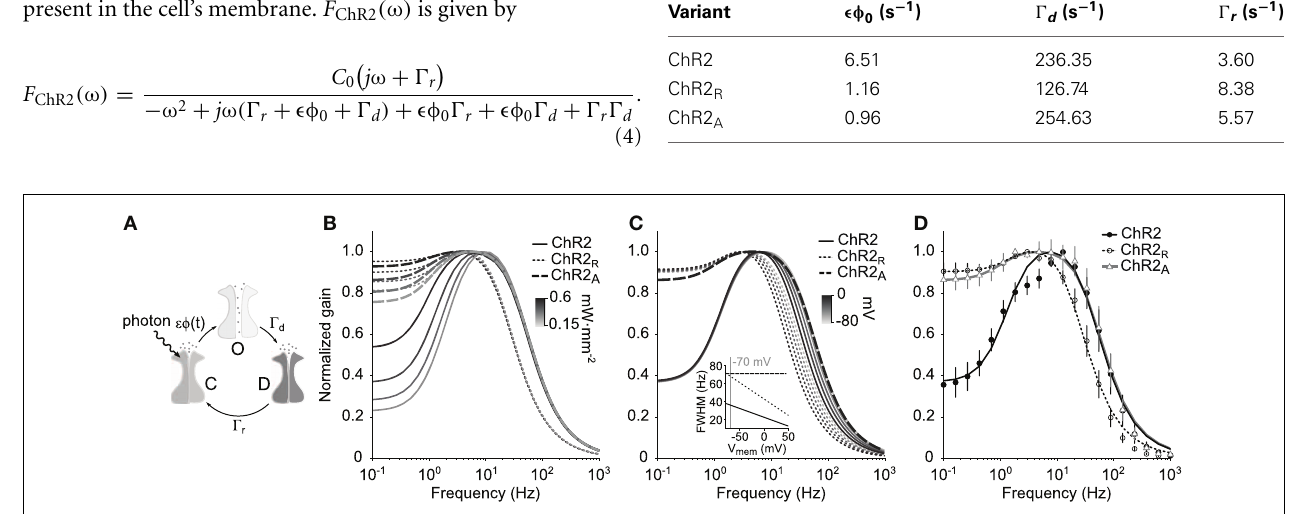
response function. ChR2 and ChR2 R both have a voltage-dependent desensitization rate, (cid:2) d ( v ) , which results in decreased bandwidth as the membrane potential increases. ChR2 A does not have a voltage dependent desensitization rate and therefore has a stable bandwidth across membrane potentials. (D) Predicted amplitude response of each ChR2 variant compared to the experimentally measured response for a mean illumination intensity of 0.35mW · mm − 2 . Error bars are ± 1